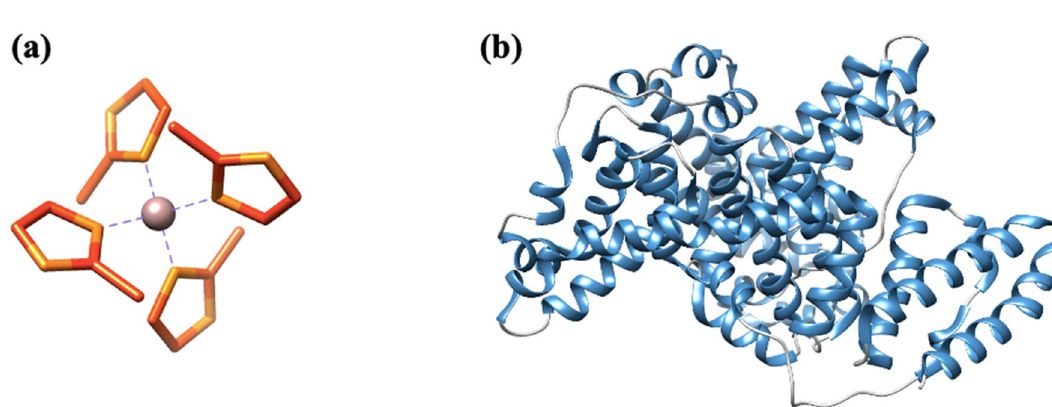
Figure 8. ( a ) Secondary building unit of ZIF-8 NPs, [Zn(2-mIm) 4 ] (Zn: purple, C: orange, N: yellow). ( b ) Structure of BSA protein chain A (α-helix: blue, random coil: